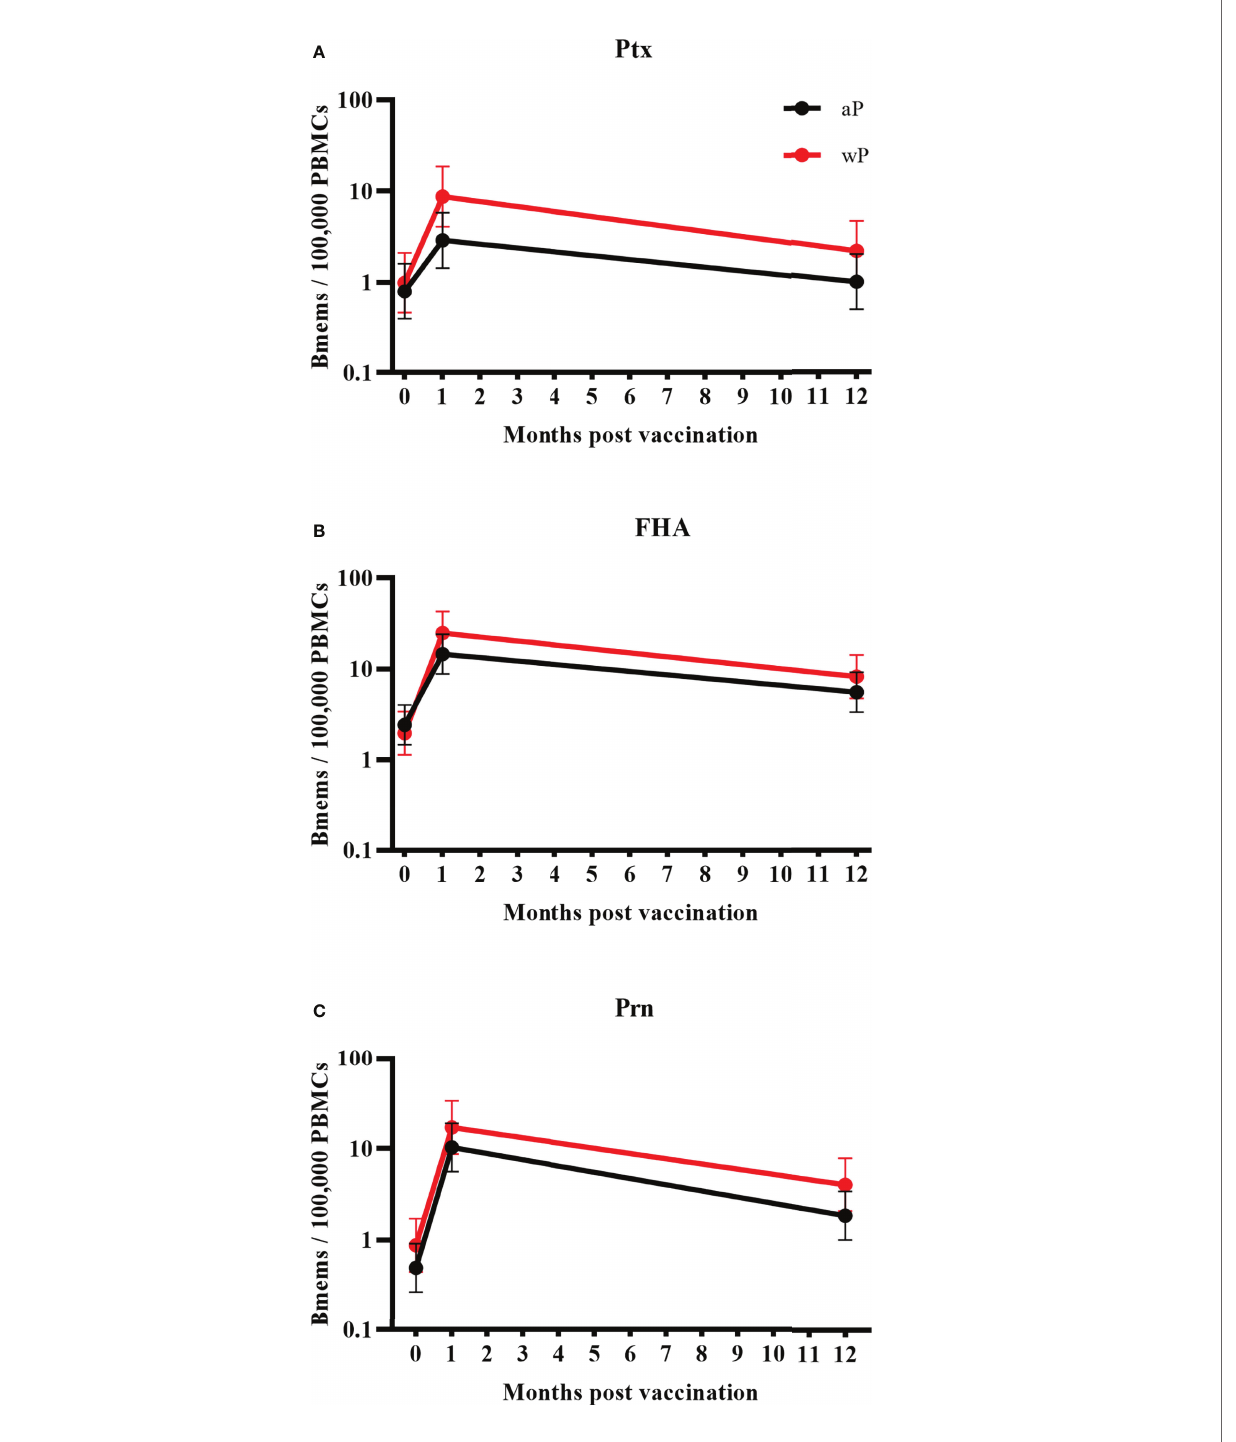
FIGURE 3 | Geometric mean memory B cell frequencies per priming vaccination background with 95% con fi dence intervals. Signi fi cances were calculated using a linear mixed model on the log10 transformed data taking the longitudinal structure into account. Bmems, memory B cell frequencies; PBMCs, peripheral blood mononuclear cells. Memory B cell frequencies in adolescents from the Netherlands and Finland together (aP priming n=22, wP priming n=18) speci fi c for (A) pertussis toxin; (B) fi lamentous haemagglutinin; and (C) pertactin. Observed differences between the aP and wP primed cohorts did not reach signi fi